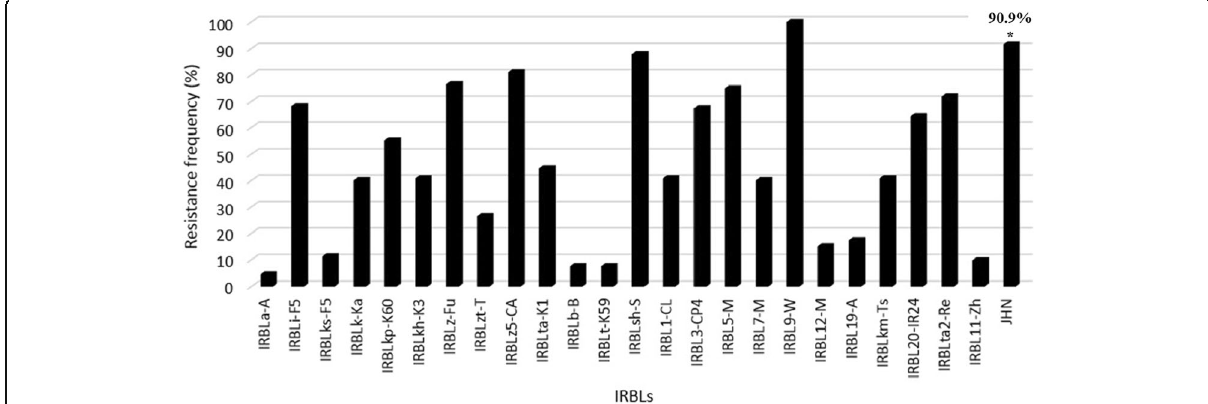
Fig. 1 The resistance frequency of IRBLs and JHN against Philippine rice blast isolates. The resistance frequency of each rice variety was calculated based on the resistance reactions against 132 Philippine isolates as listed in Additional file 1: Table S1. The resistance frequency of JHN was indicated on the top of the